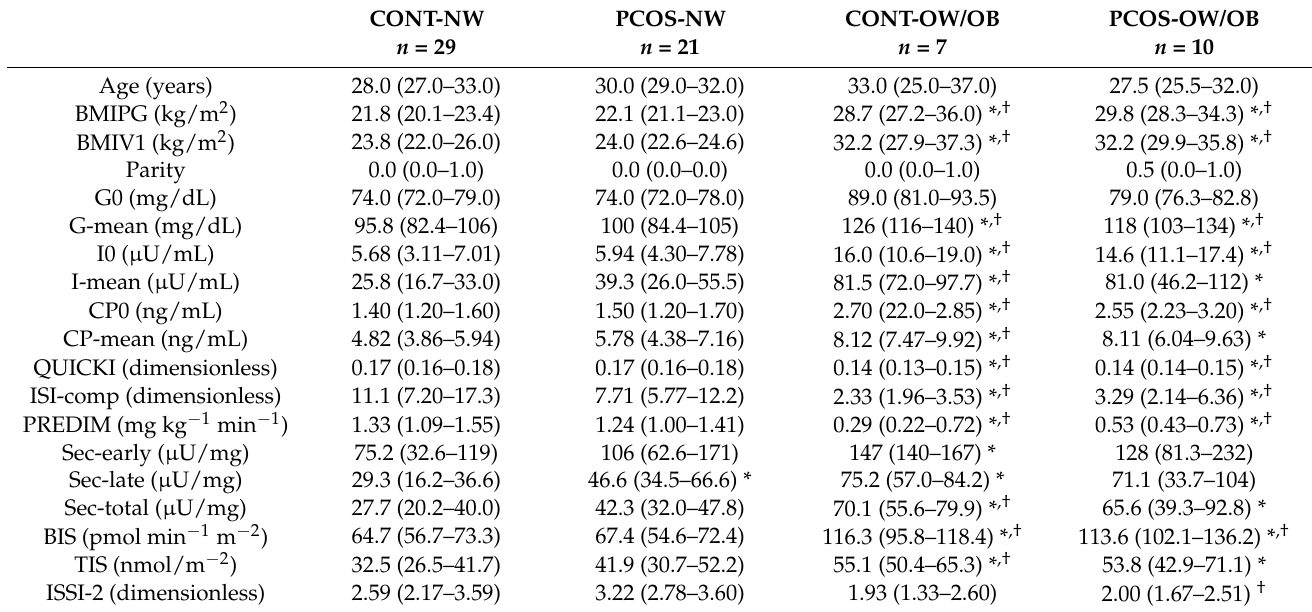
Table 1. Glucometabolic parameters of the study sample at early gestation (visit 1: 12 + 0 to 22 + 6) for normal weight vs. overweight/obese women with polycystic ovary syndrome and